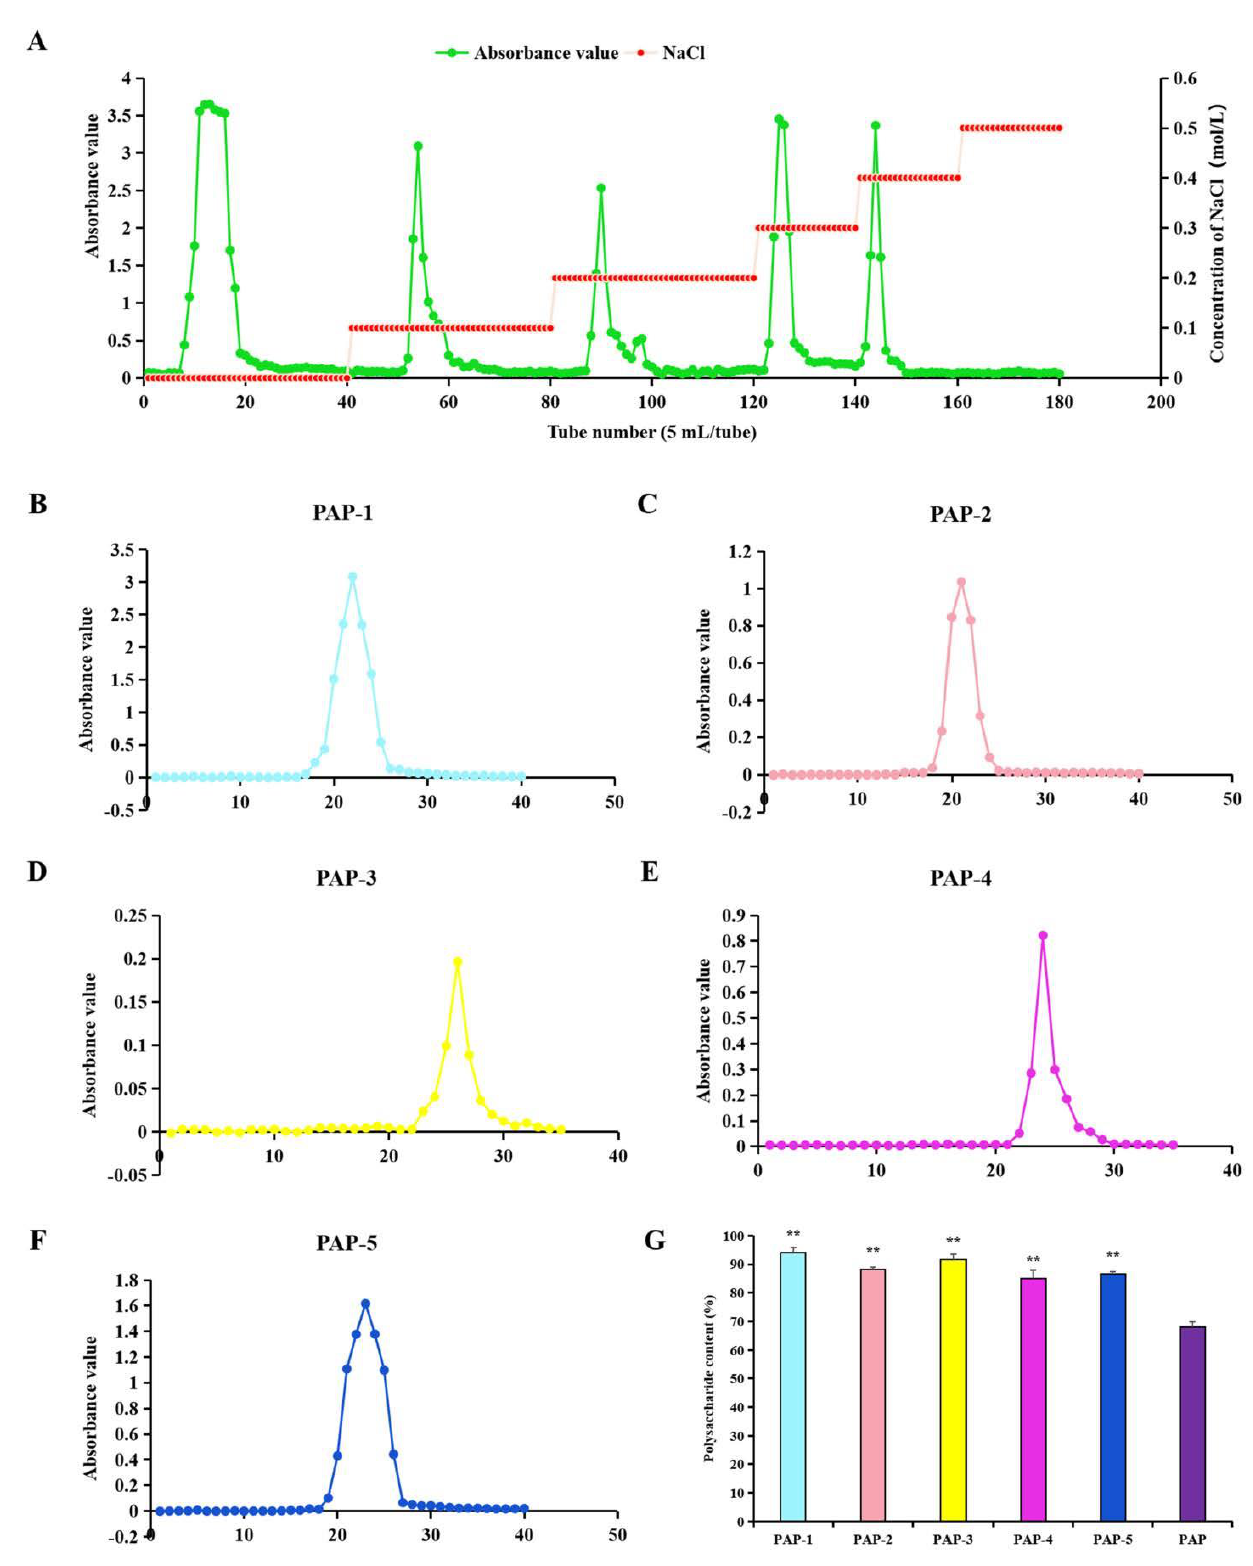
Figure 2. The elution curve of PAP was separated and purified by Cellulose DE-52 chromatography column ( A ) and Sephacryl S-200 high-resolution chromatography column ( B – F ) respectively; ( G ) Polysaccharide content of PAPs (means ± SD, n = 3). Bars with ** indicates most significant difference with other groups ( p <